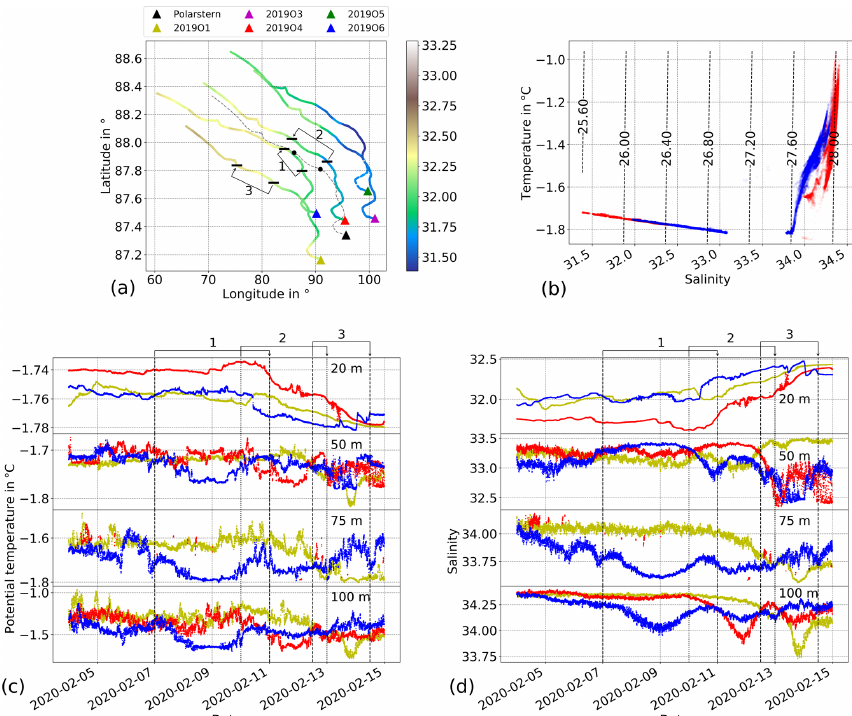
Figure 7. Preliminary observations of an eddy passing through the DN in February 2020. (a) Trajectories and observed salinity at 10m depth of five buoys (colored) along with trajectory of R/V Polarstern (black) between 2 and 20 February 2020. Triangles indicate the buoy positions on 2 February. The black horizontal lines with numbered bars indicate the start and end positions of the times in panels (c) and (d) , where changing water properties were observed by the corresponding buoy. (b) T − S diagram of buoy data at 20 and 100m depth during 1 to 20 February 2020 (red) and 20 February to 1 March 2020 (blue). (c, d) Temperature and salinity recorded at four different depths by buoys 2019O1, 2019O4, and 2019O6. The line colors correspond to the triangle colors in panel (a) .